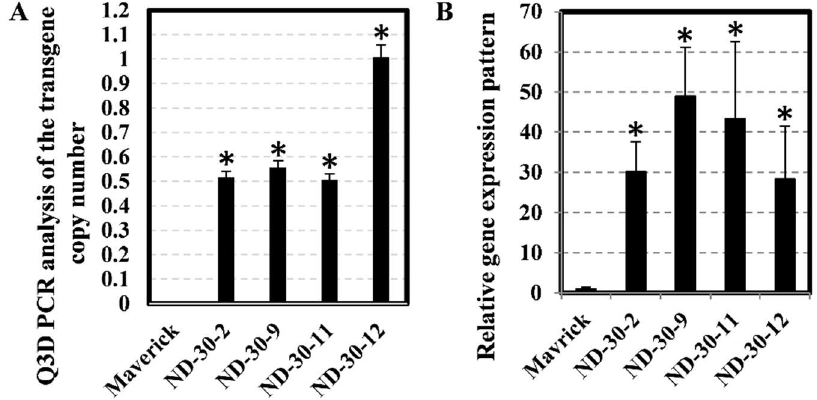
Figure 6. Calculation of transgene AtXTH31 copy numbers and relative expression levels in four transgenic events. ( A ) Ratios of copy number between AtXTH31 and lectin gene (Glyma.02G009600) were determined by digital PCR in soybean T0 transgenic generation. Soybean transgenic plants contained a single insert copy when the ratio value was equal to 0.5 and two insert copies when the ratio value was equal to 1. ( B ) The relative expression of AtXTH31 in T3 homozygous transgenic soybean roots determined by qRT-PCR. The relative levels of transcripts were normalized to the soybean actin gene (Glyma.18G290800). Bars represent mean values of three biological replicates (standard error). * indicates significantly different at p < 0.05 as tested by Fisher’s least significant difference. Non-transgenic Maverick soybean as a control and MYB2:AtXTH31 transgenic soybean lines ND-30-2, ND-30-9, ND-30-11, and ND-30-12 with overexpression of AtXTH31 were studied.